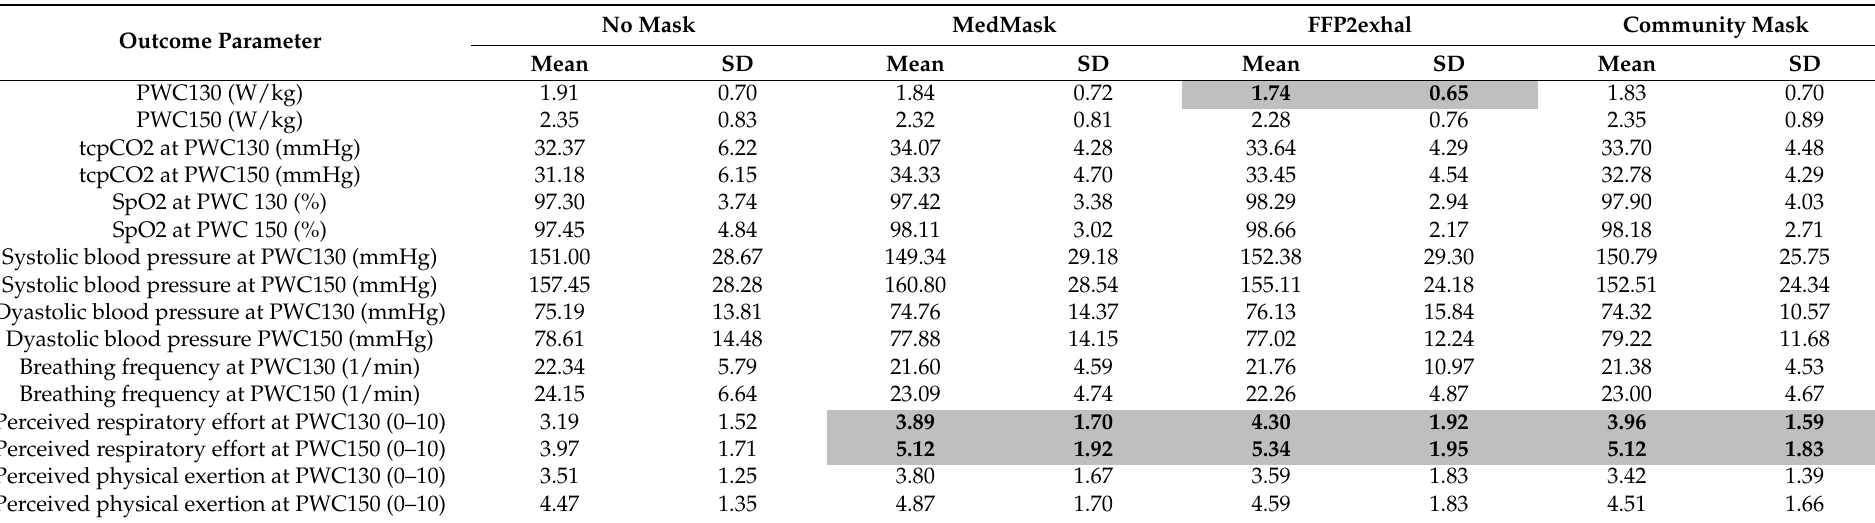
Table 3. Mean values of all assessed outcome parameters during the four experimental